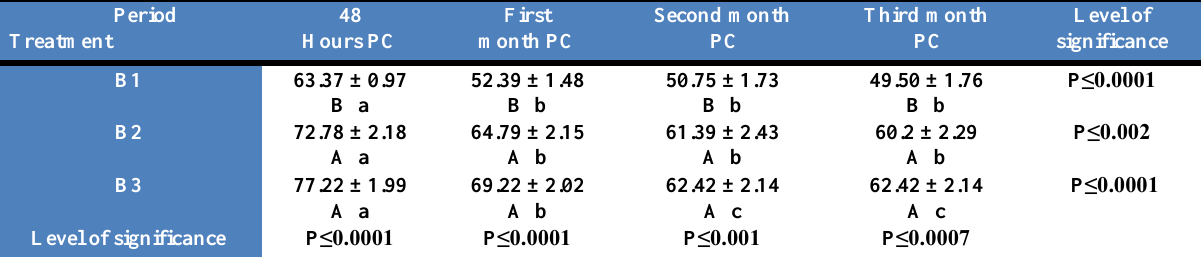
Means with capital superscripts within each column indicate comparison among treatments and small superscripts within each row indicate comparison among periods within each treatment. A1: Tris extender (Control group). A2: Tris extender + 0.7 mM manganese chloride. A3: Tris extender + 0.9 mM manganese chloride. Table2. The Effect of adding Co-Q10 to Tris extender on the freeze ability percentage (FA%) different post- cryopreservation (PC) periods in Holstein bulls semen (M ±S.E).